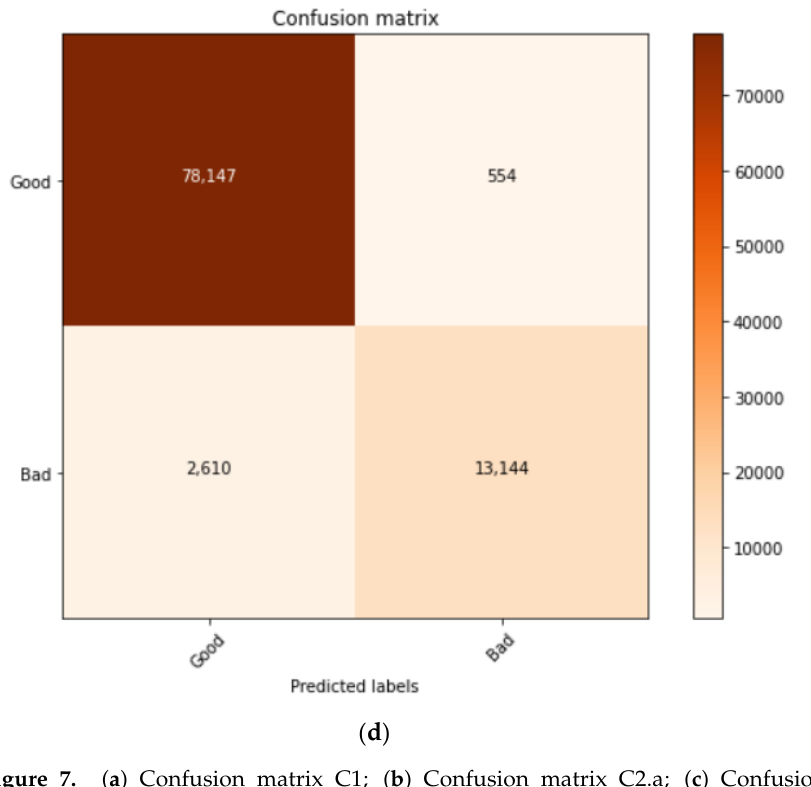
Figure 7a – d . ( a ) Confusion matrix C1; ( b ) Confusion matrix C2.a; ( c ) Confusion matrix C2.b. ( d ) Confusion matrix proposed method.